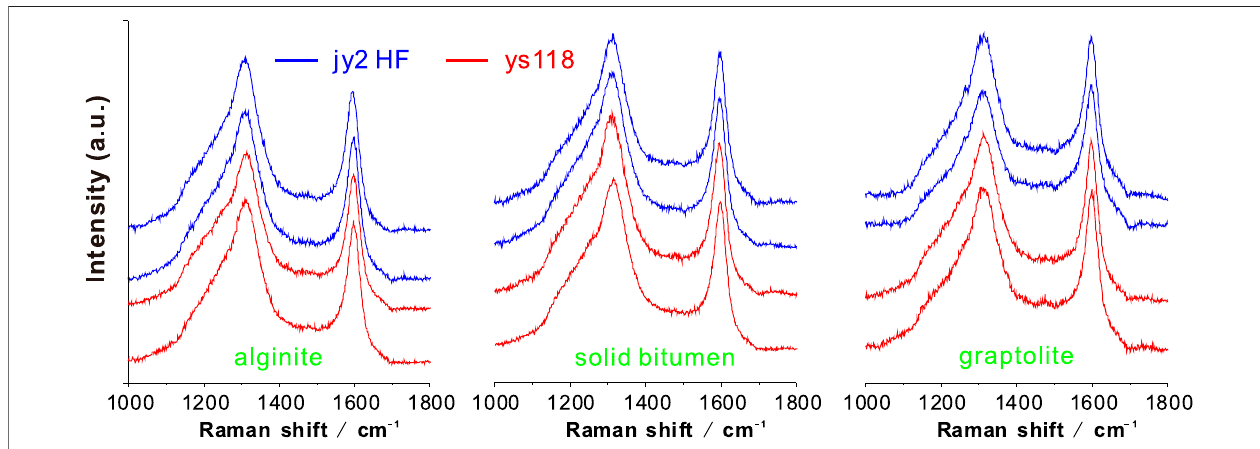
FIGURE 6 | Raman spectroscopy of alginite, solid bitumen, and graptolites in two samples, in which the blue line is the jy2 HF sample and the red line is the ys118 sample.